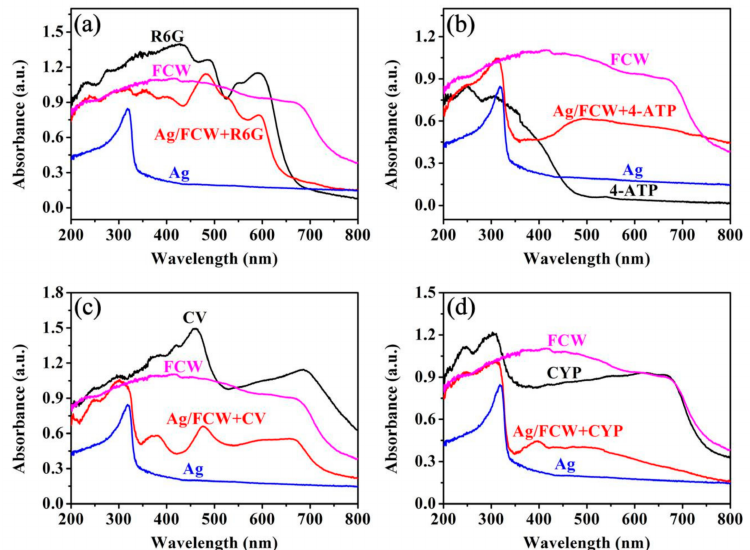
Figure 5. The comparison of UV-vis absorption spectra of: ( a ) R6G, Ag, Fulfora candelaria wing (FCW) and Ag/FCW-10 substrates absorbed with R6G molecules; ( b ) 4-ATP, Ag, FCW and Ag/FCW-10 substrates absorbed with 4-ATP molecules; ( c ) CV, Ag, FCW and Ag/FCW-10 substrates absorbed with CV molecules; and ( d ) CYP, Ag, FCW and Ag/FCW-10 substrates absorbed with CYP molecules.